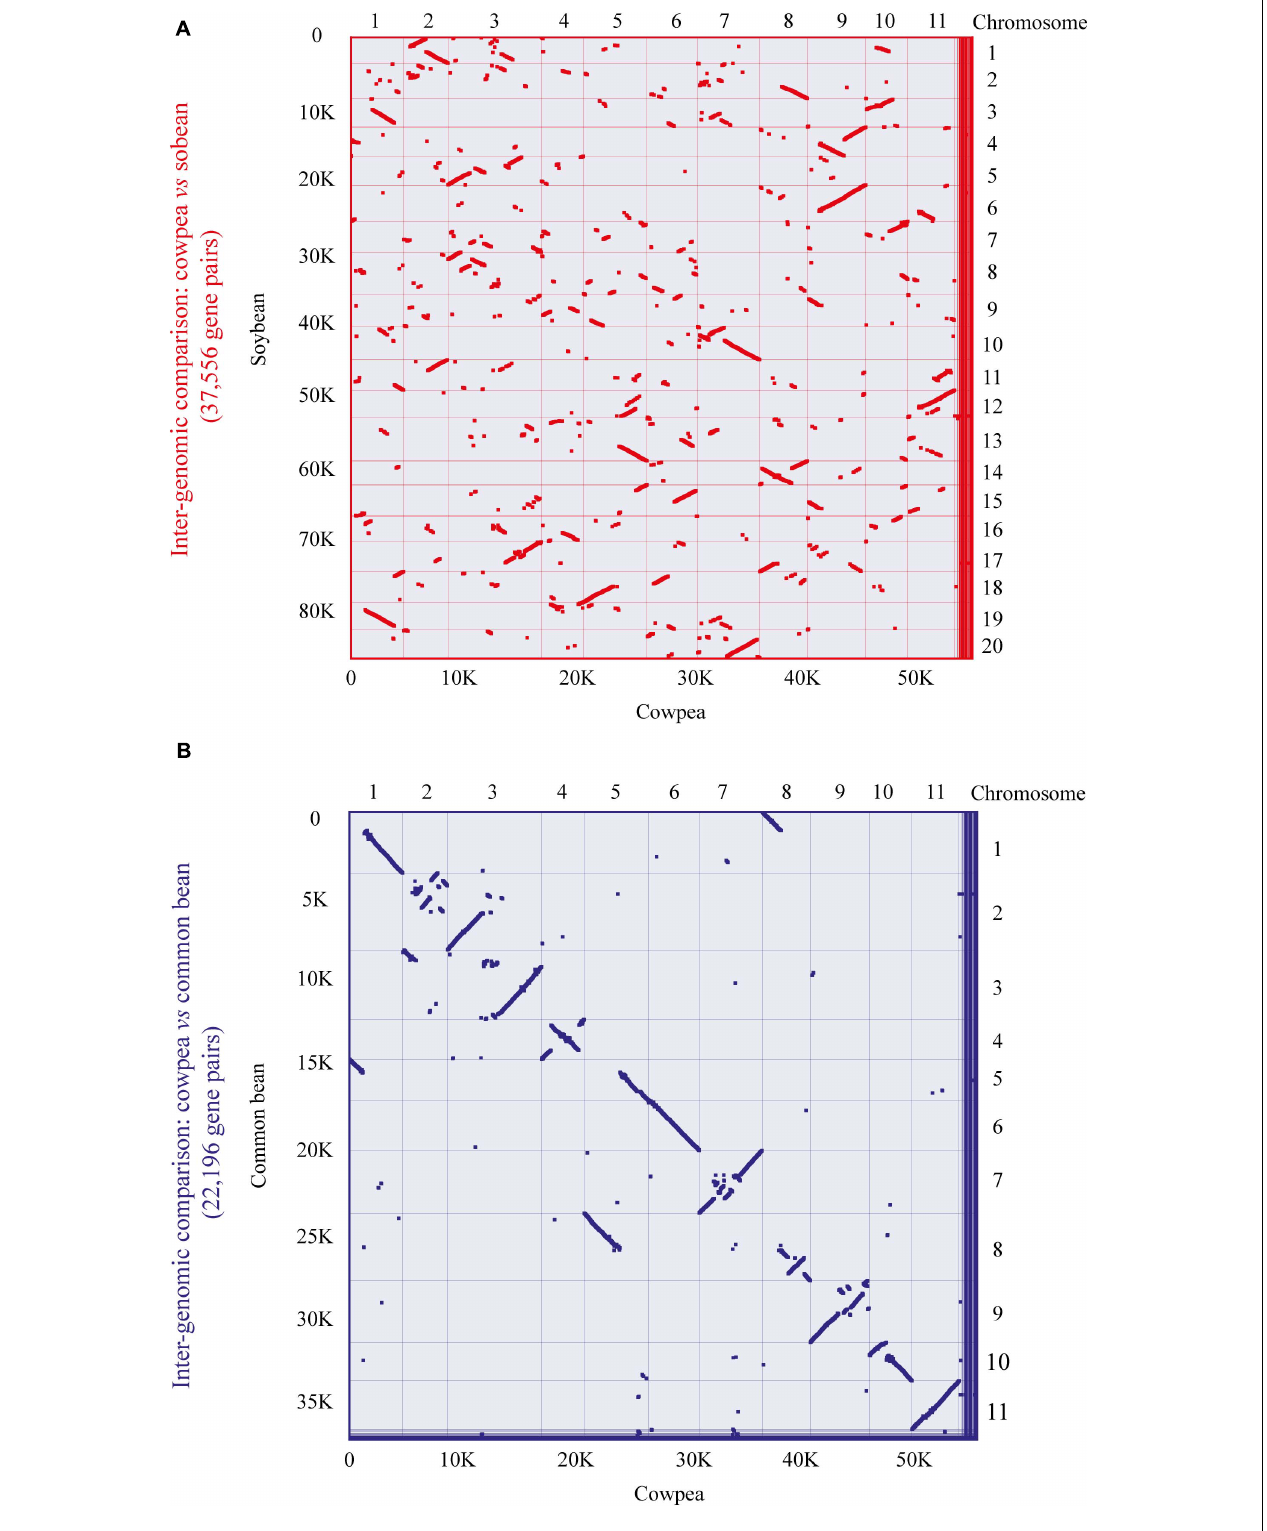
FIGURE 4 | Comparative genomics between cowpea and two other crop legumes. (A) Macrosyntenic dot plot of the cowpea and soybean chromosomes. (B) Macrosyntenic dot plot of the cowpea and common bean chromosomes. Each red or blue dot represents a syntenic region (comprising at least five genes) between the two respective